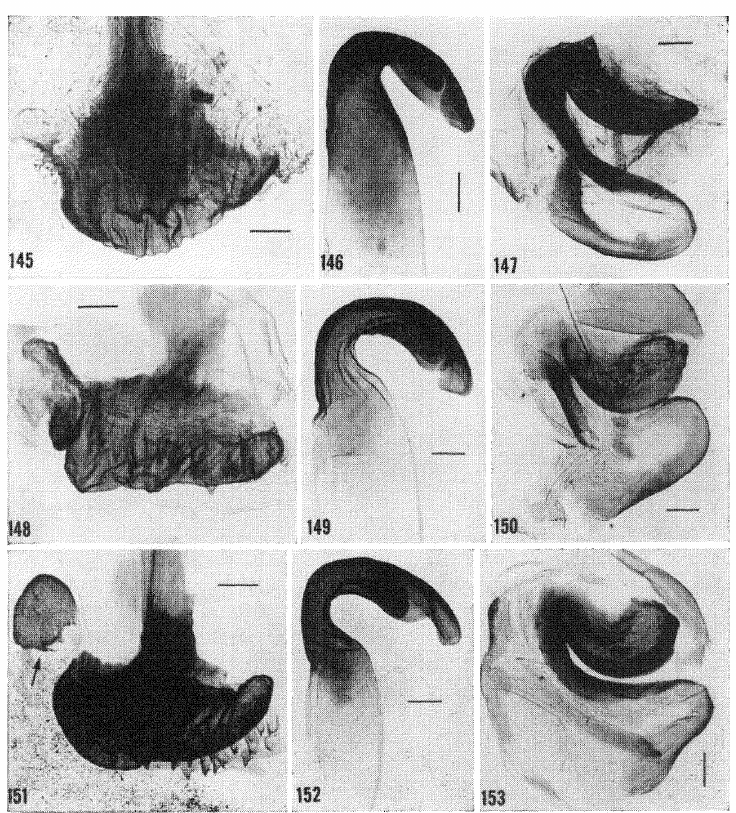
Figs. 145-153. 145-147. (42 CUZM). ,Monachoda latissima. (from speci- men shown in Fig. 123). 148-150. (964 L). Hiereoblatta cassidea. (from specimen shown in Fig. 126). 151-153. (120 ANSP). Hiereoblatta cassidea. Paratype of Monastria semialata Saussure. Capivary, Santa Catharina, Brazil (from specimen Fig. 23 in Rehn, 1937). A piece of L2d (arrow, Fig. 151) is torn away from the main body of the selerite. (scale 0.3